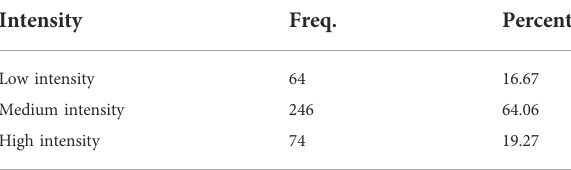
TABLE 4 Classi fi cation of tobacco farmers ’ adoption